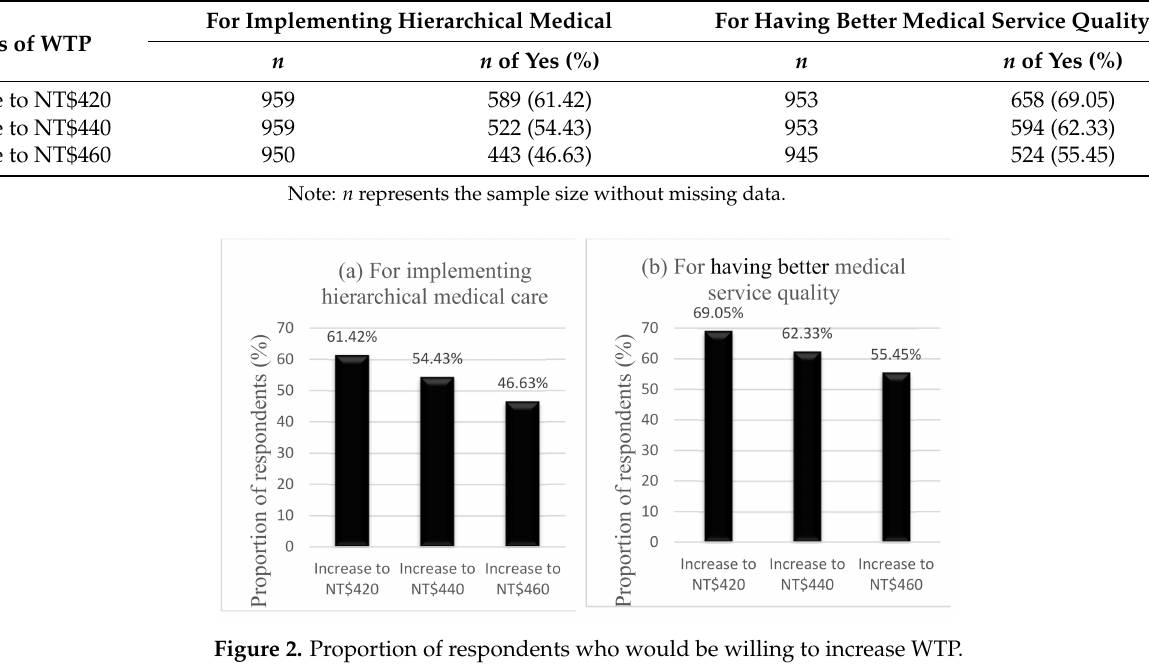
Table 5. Numbers and proportions of respondents in the different levels of WTP.